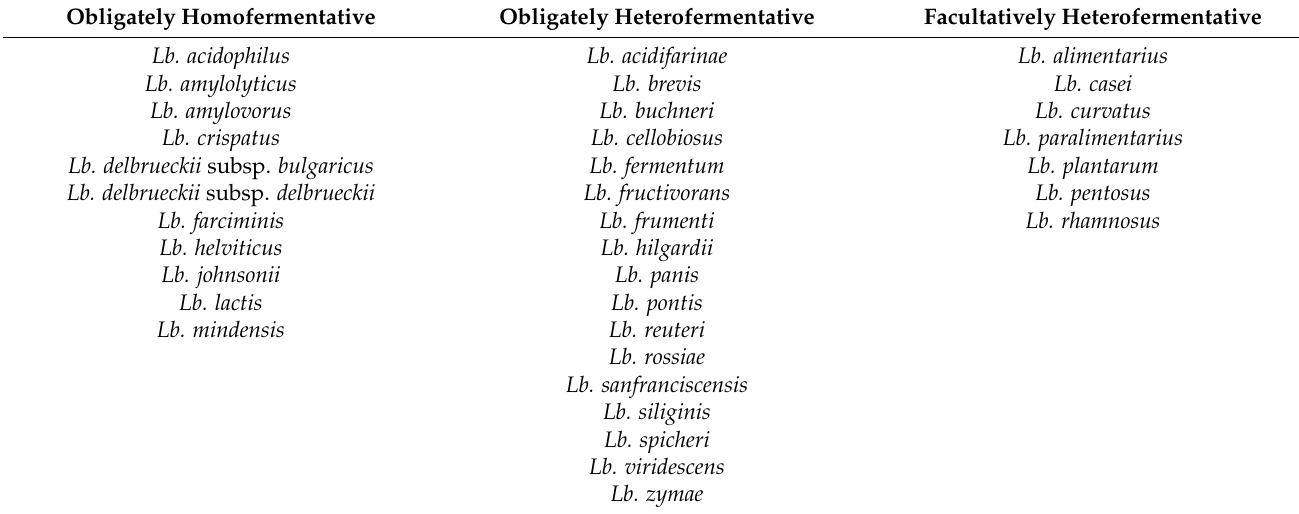
Table 4. Lactobacilli isolated from sourdoughs [1,102,105,106]. Obligately Homofermentative Obligately Heterofermentative Facultatively